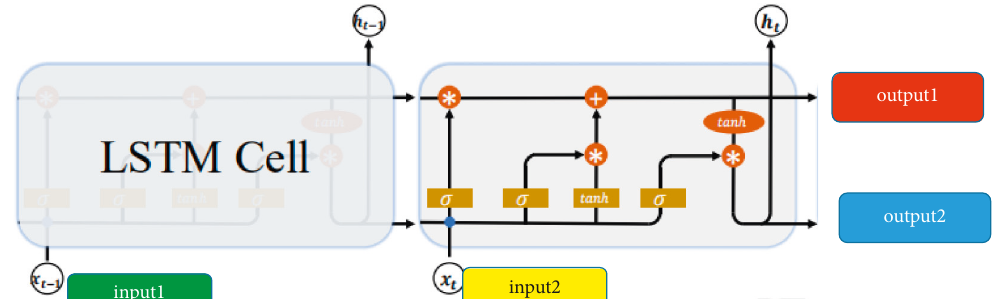
Figure 3: The working principle of the LSTM